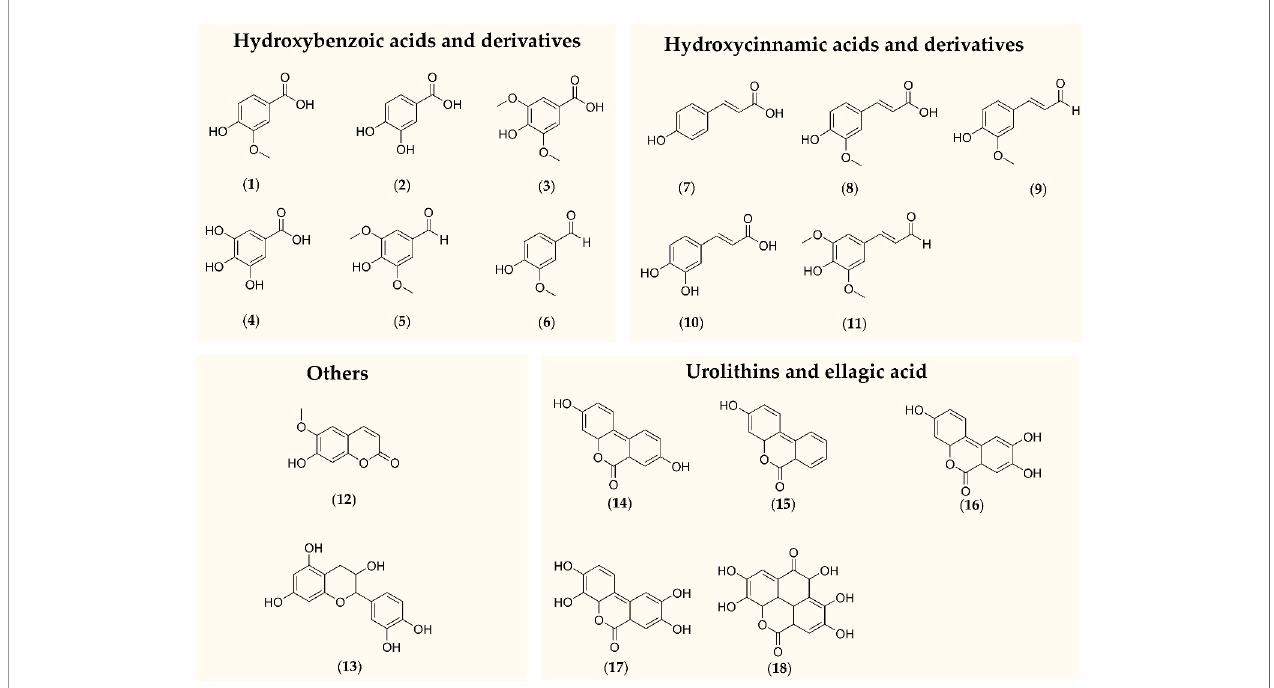
FIGURE 1 | Polyphenols and metabolites that were subject of this study. (1) Vanillic acid, (2) protocatechuic acid, (3) syringic acid, (4) gallic acid, (5) syringaldehyde, (6) vanillin, (7) para-coumaric acid, (8) ferulic acid, (9) coniferaldehyde, (10) caffeic acid, (11) sinapinaldehyde, (12) scopoletin, (13) +-catechin, (14) urolithin A,